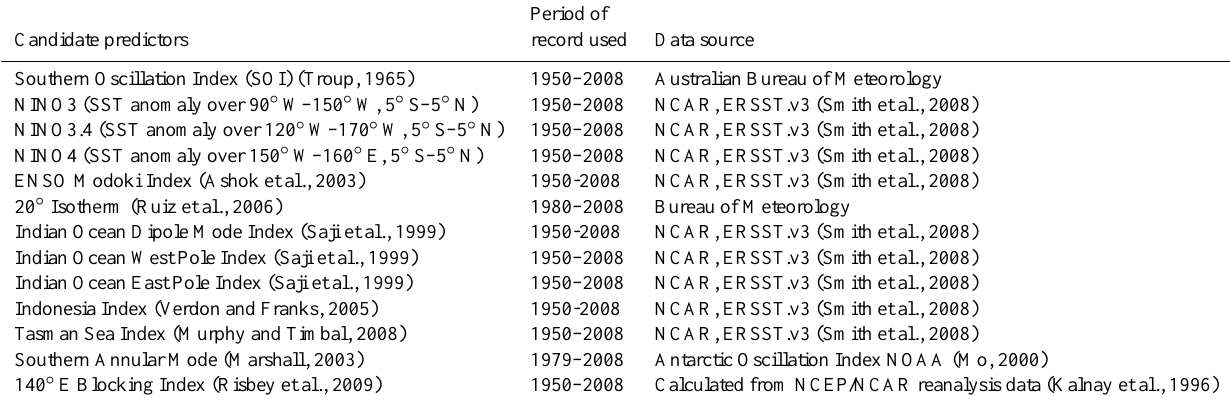
Table A1. Climate indices included as candidate predictors of seasonal forecast of streamflow and data